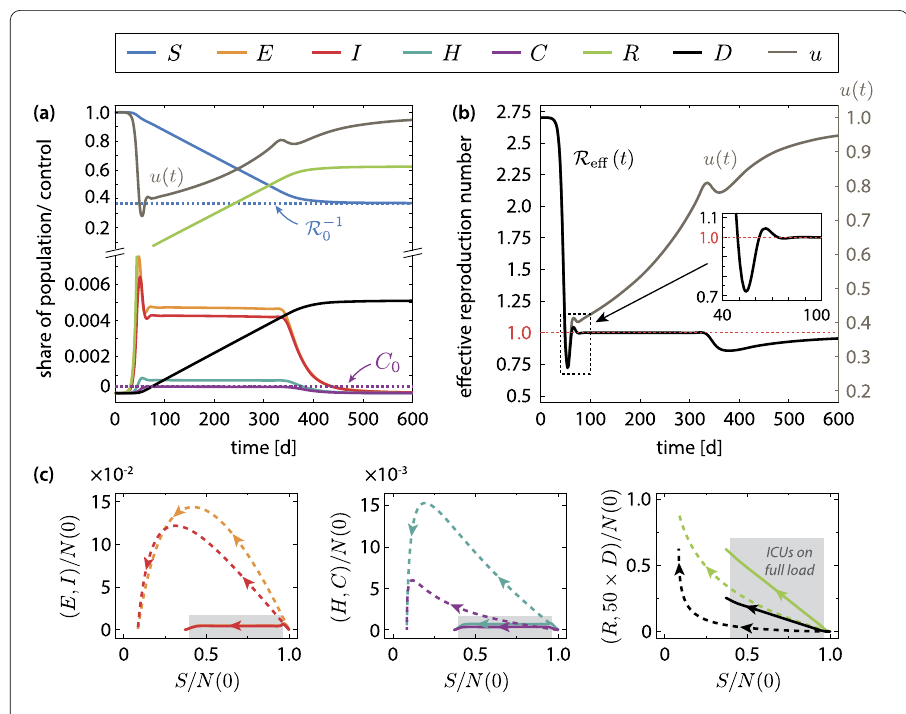
Figure 4 Optimal transmission control for C 0 = 30,000 available ICUs. ( a ) Temporal evolution of the optimally controlled epidemic. The susceptible population terminates slightly below the critical value R –1 0 , which guarantees herd immunity and rules out a second wave of the epidemic. Moreover, the optimal control ensures that the available number of ICUs is not exceeded by the critically ill: C ( t ) < C 0 for all t ∈ [0, ∞ ). A more detailed plot of the ICU load is given in Fig. 5(c). ( b ) Effective reproduction number (6) corresponding to the optimally steered intervention. The optimal mean contact reduction u ( t ) is shown for comparison. ( c ) Comparison of the trajectories of the uncontrolled (dashed lines) and the optimally controlled epidemic (solid lines) in different projections of the state space. The arrows indicate the direction of time. The grey shaded region highlights the critical